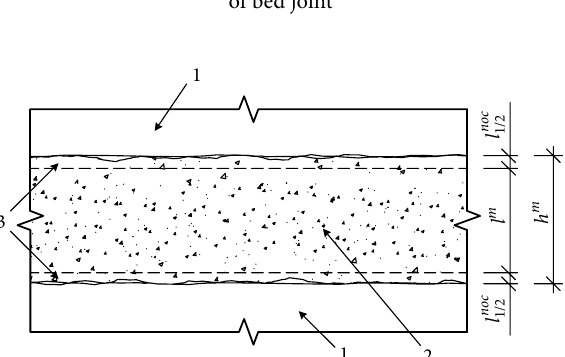
Fig. 10. The scheme of defining the elastic modulus of bed joint